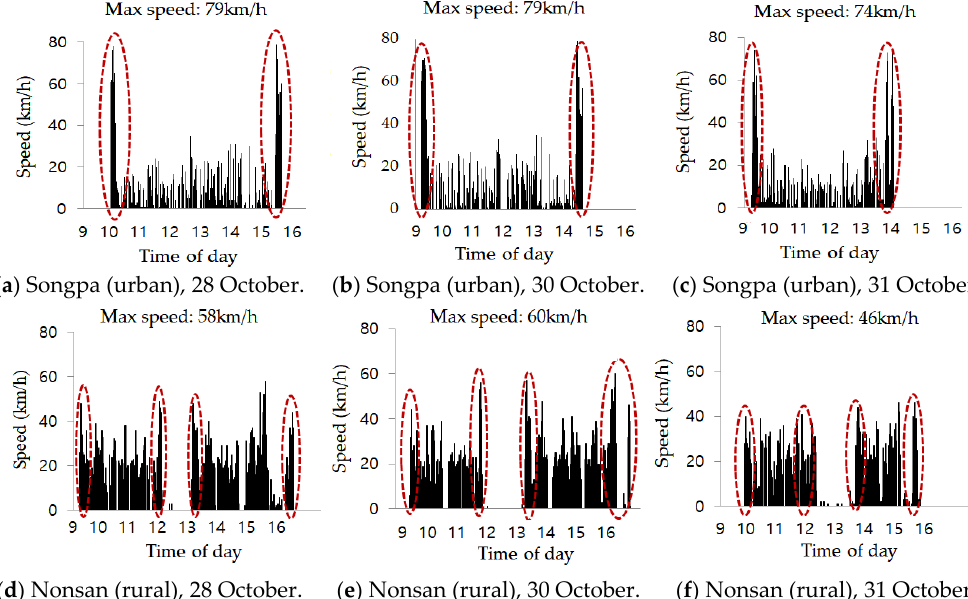
Figure 5. Distribution of speed by time of day, collected by two postal motorcyclists working in Songpa (urban) and Nonsan (rural), respectively. Speeds on the commutes to and from the post office are marked with circles.